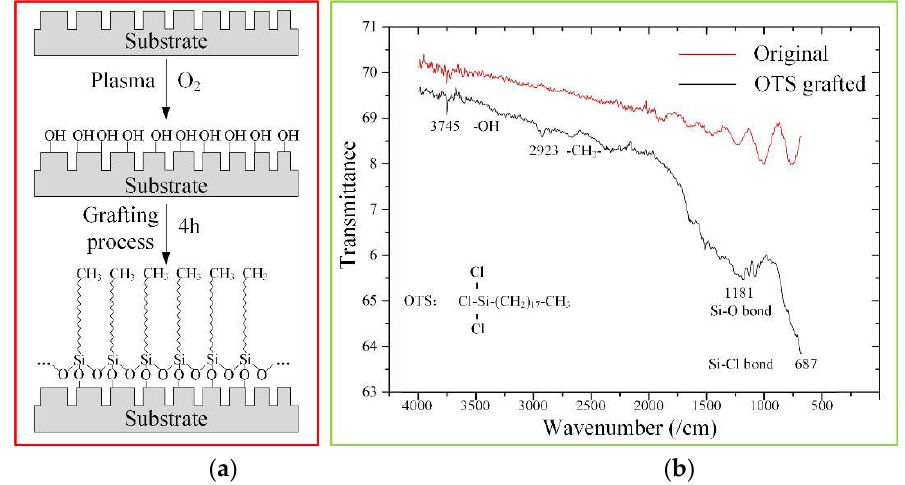
Figure 3. Surface modification of the substrate. ( a ) Schematic of self-assembly thin layer of octadecyltrichlorosilane (OTS) grafting process; ( b ) ATR-FTIR spectra of the substrate before (red line) and after (dark line) self-assembled thin layer of OTS grafts.